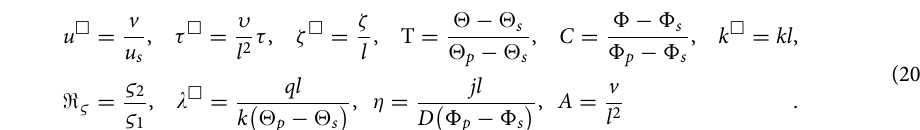
Tables 1 and 2 represent the correlation of base fluid and nanoparticles and their thermo-physical properties respectively. Introducing the non-dimensional quantities;